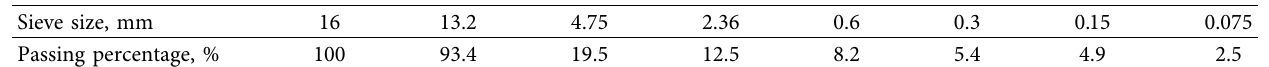
Figure 1: Research methodology. Table 1: Gradation of